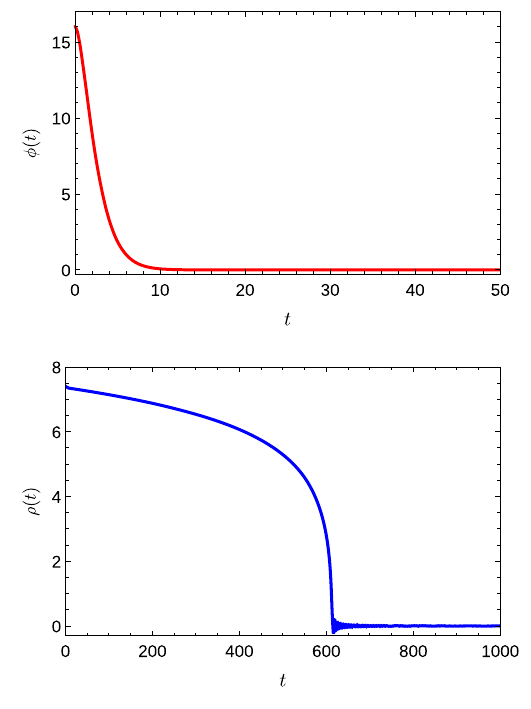
Fig. 2 Top: the field φ( t ) as a function of time. Bottom: the field ρ( t ) as a function of time